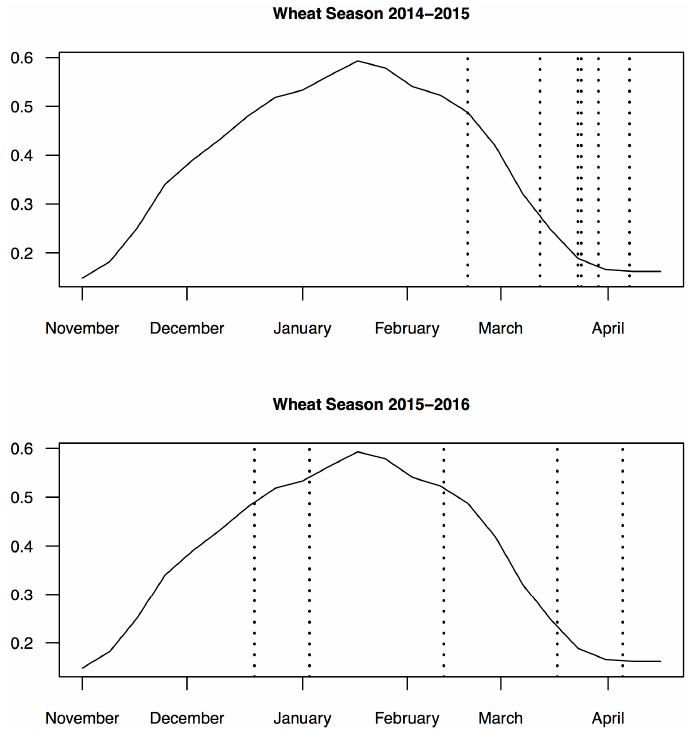
Figure 2. Graph showing the phenology of one example wheat pixel using 16-day MODIS Terra imagery in our study region. Dates when SkySat images were available are highlighted with vertical dashed lines.